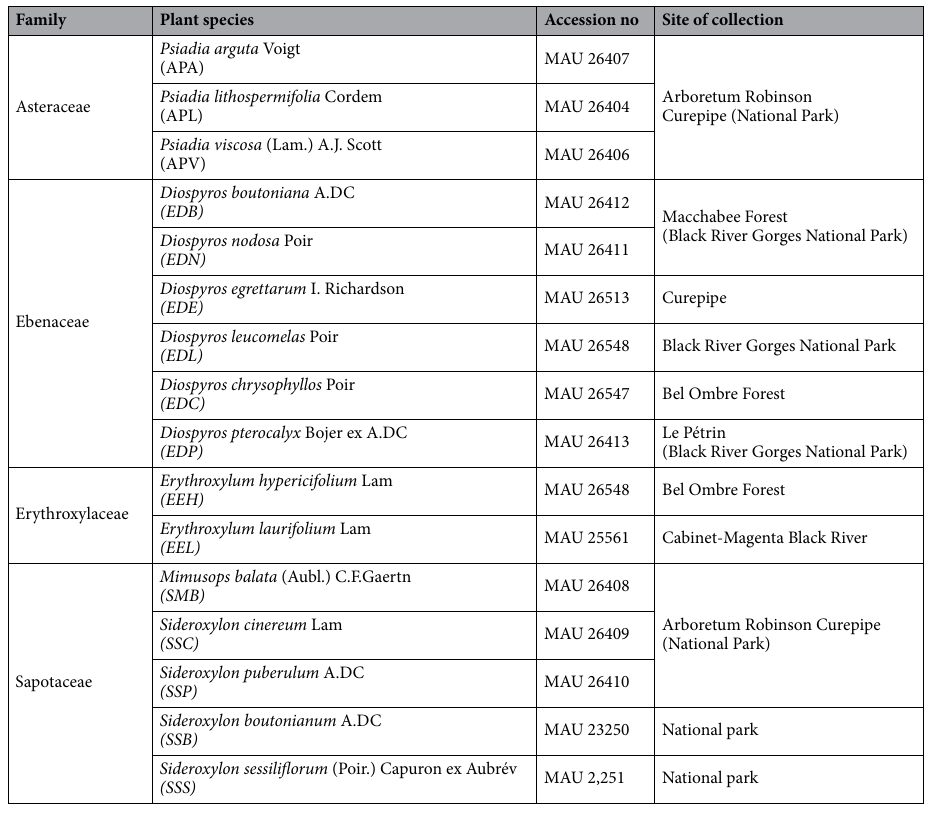
Table 1. Mauritius endemic plant species. *Plant sample site location are represented in Fig.